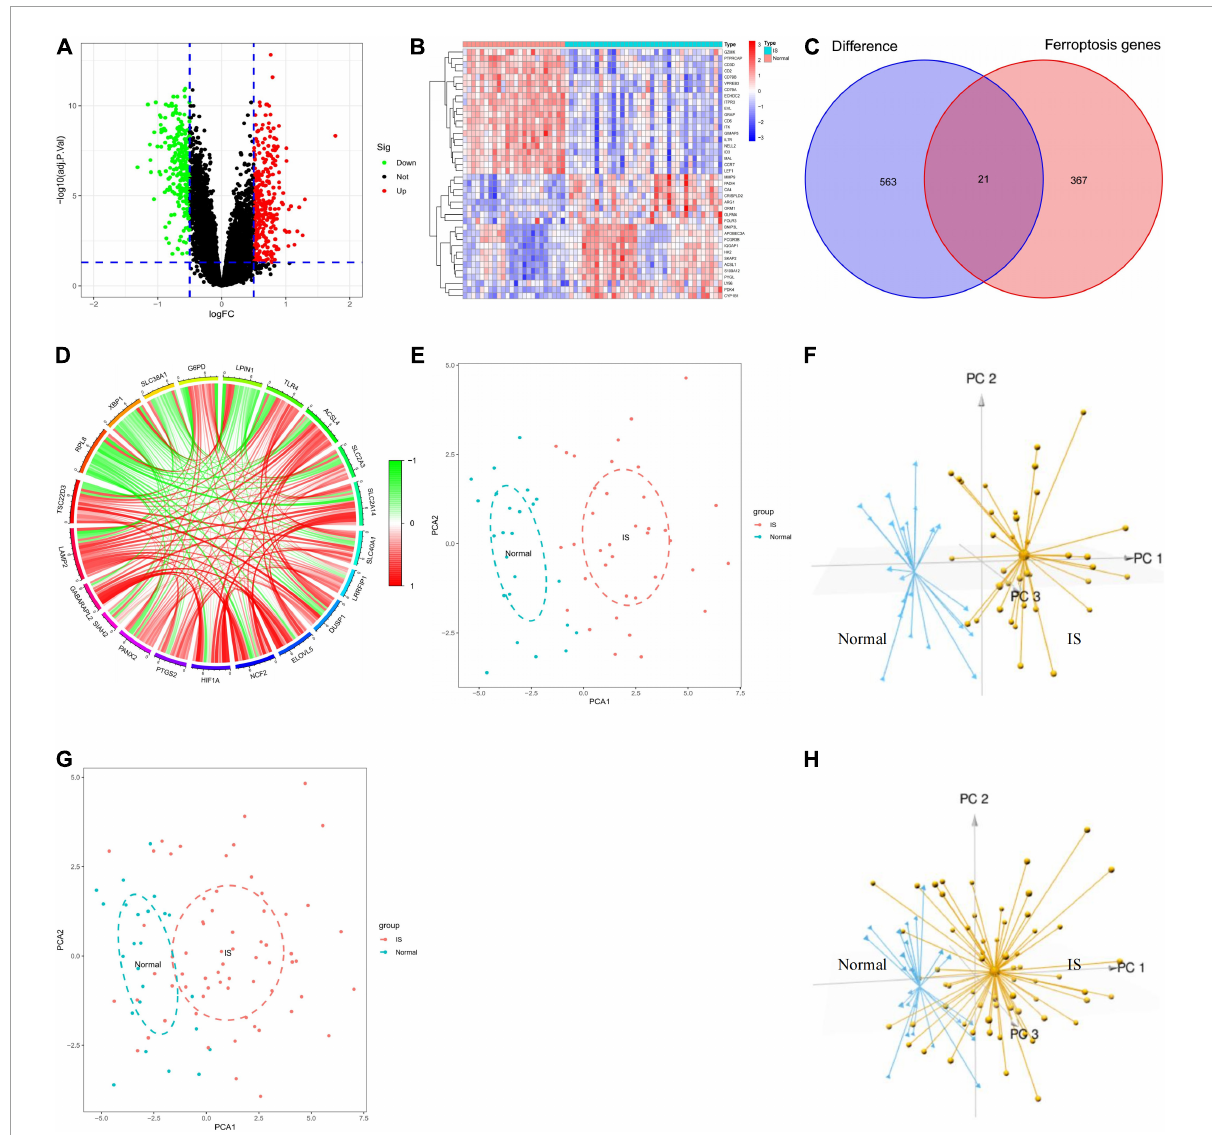
FIGURE3 Analysis of differentially expressed genes. (A) Screening of DEGs shown by volcano plot. (B) Heatmap of the 40 genes expressed differently in IS samples compared to normal samples. (C) Venn diagram showing 21 ferroptosis-related DEGs. (D) Circle diagram showing the correlation of 21 ferroptosis-related DEGs. (E,F) 2D and 3D PCA plots showing PCA analysis based on 21 ferroptosis-related genes in GSE16561. (G,H) 2D and 3D PCA plots showing PCA analysis based on 21 ferroptosis-related genes in GSE37587. DEGs, differentially expressed genes; IS, ischemic stroke; PCA, principal components